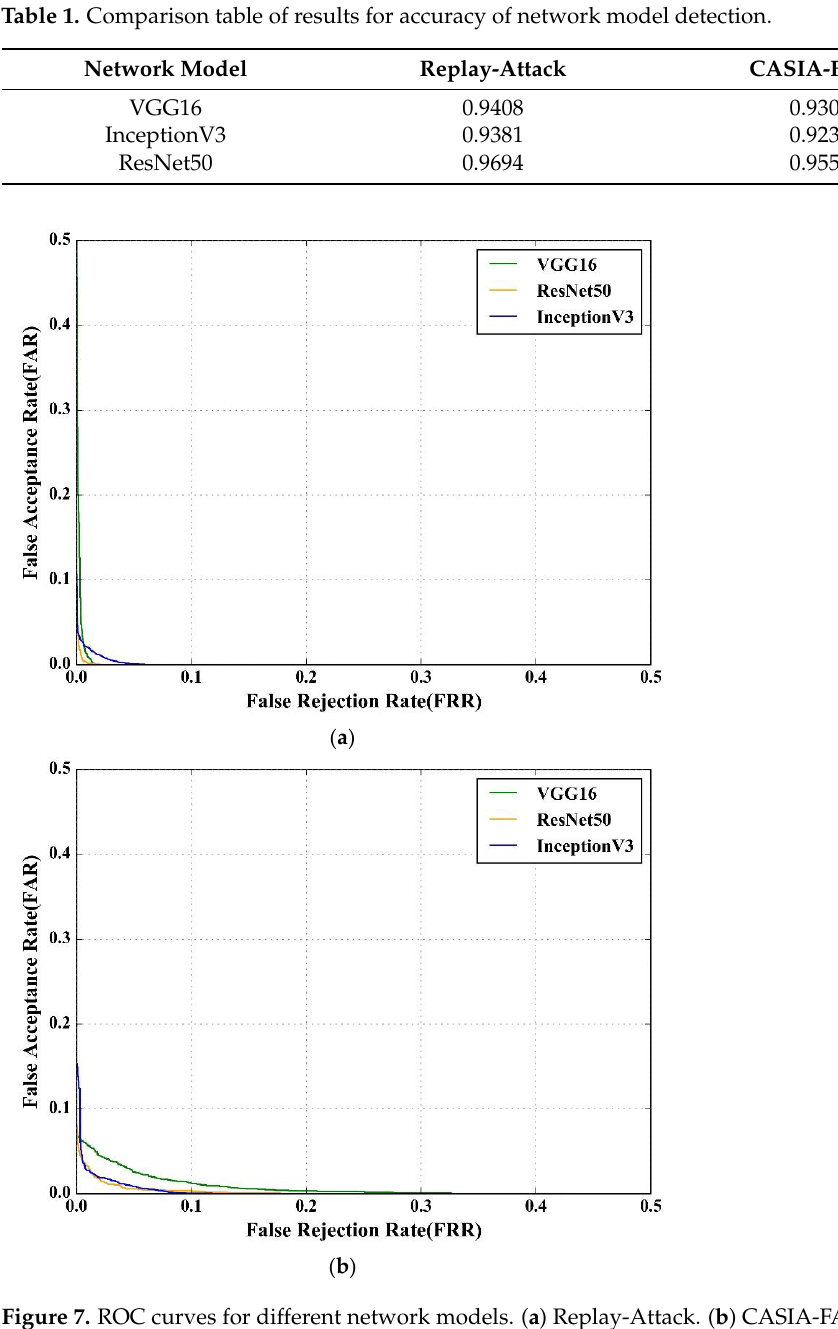
Figure 7. ROC curves for different network models. ( a ) Replay-Attack. ( b ) CASIA-FASD.